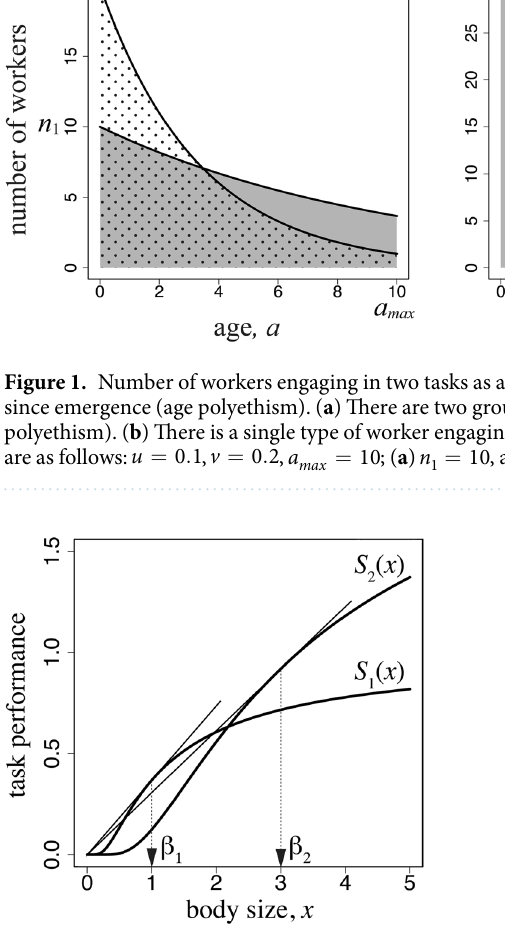
Figure 2. Task performance as a function of worker body size. The parameters used are as follows: α = . 1 0